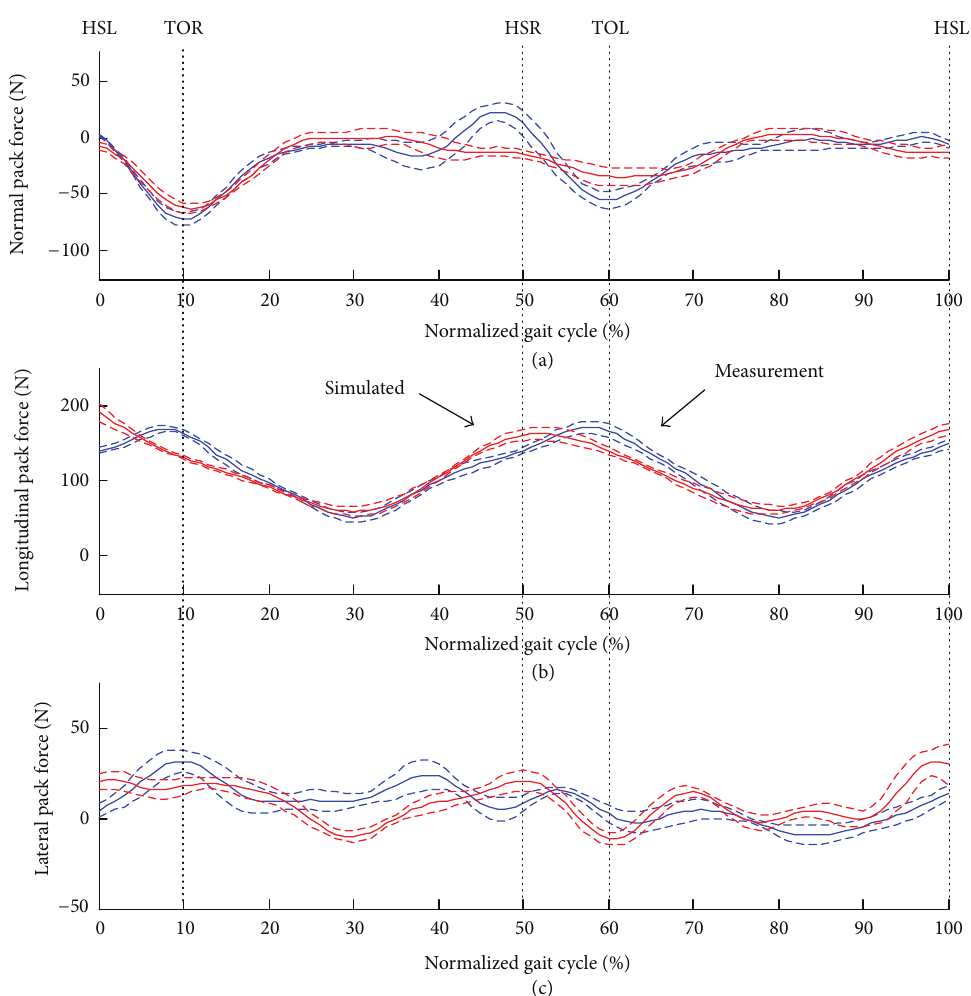
Figure 7: The simulated pack interaction forces in the pack coordinate system mean ((solid red line)) ± one standard deviation (dashed red lines): (a) longitudinal pack force, (b) normal pack force (c) and lateral pack force, compared with measured data (mean (solid blue line) ± one standard deviation (dashed blue lines)), for six repeated trials for one subject (age: 28yrs, weight: 71.8 kg, height: 178cm). The average walking speed was 1.63 ± 0.03 m/s, and the pack load was 11.5kg. The stance phase for the left limb is from 0 to 60%, and the swing phase is from 60% to 100%. The double support phase is from 0 to 10% and from 50 to 60%.